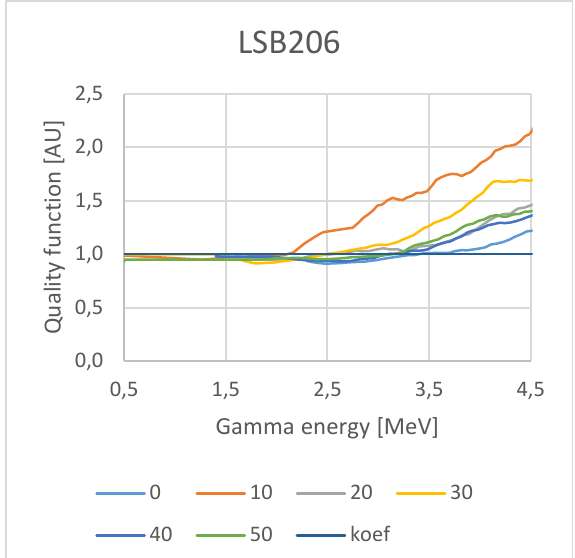
Fig. 3. FOM temperature dependencies of the